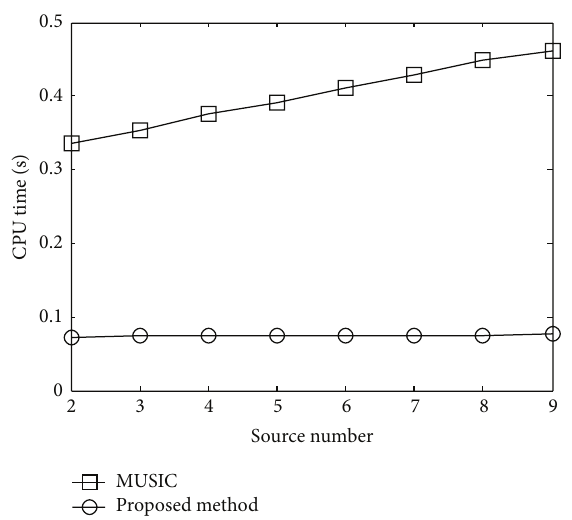
Figure 9: CPU time comparison, 𝑁 = 6 , 𝐿 = 1024 , and 𝑀 = 32